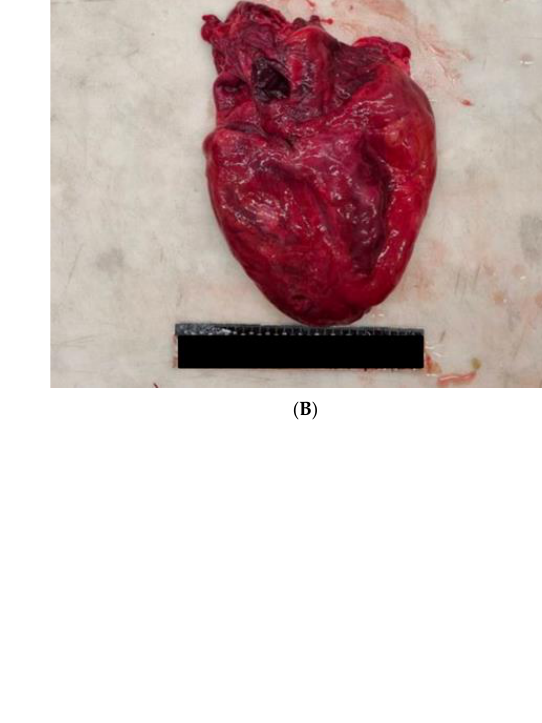
tion) and hypoxia secondary to hemorrhagic airway flooding.